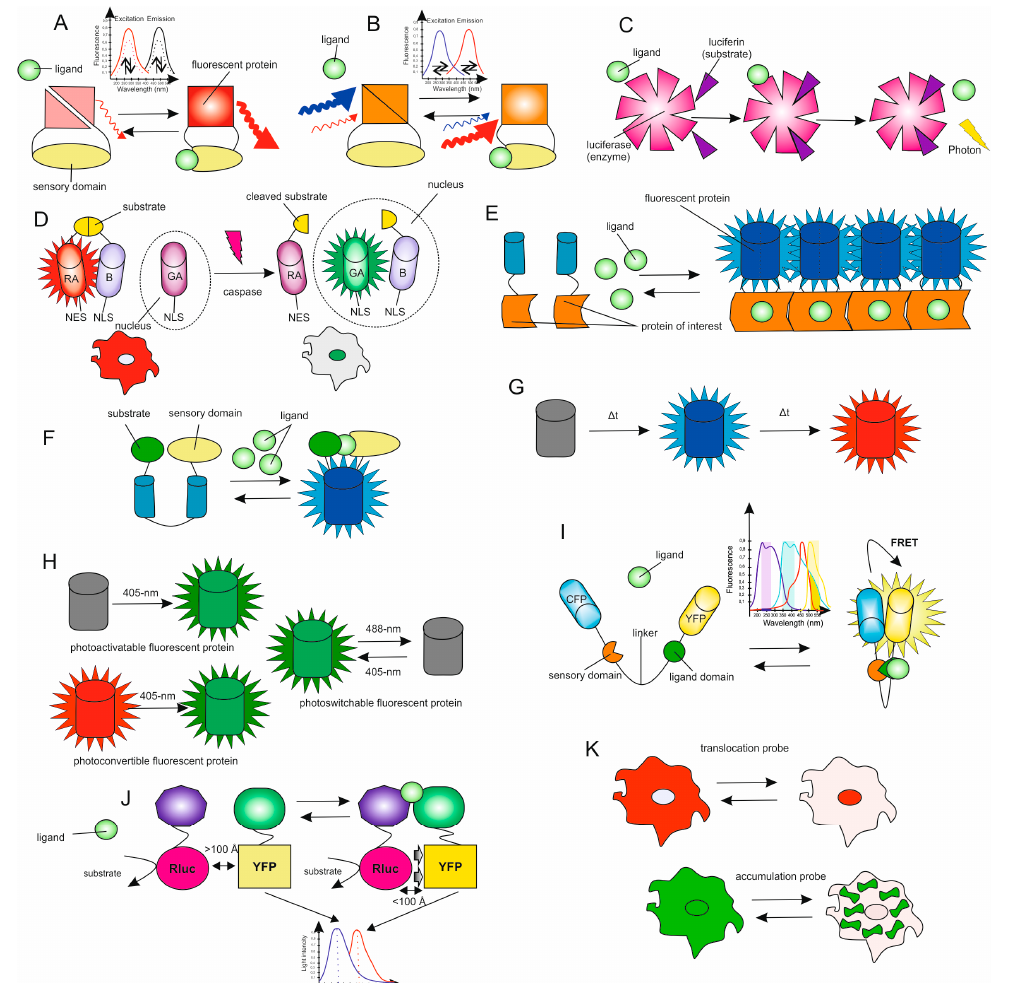
Figure 2. Biosensors classes. Rluc— Renilla luciferase, YFP—yellow fluorescent protein, CFP—cyan fluorescent protein, RA—red copy-A, GA—green copy-A, NLS—nuclear localization signal,